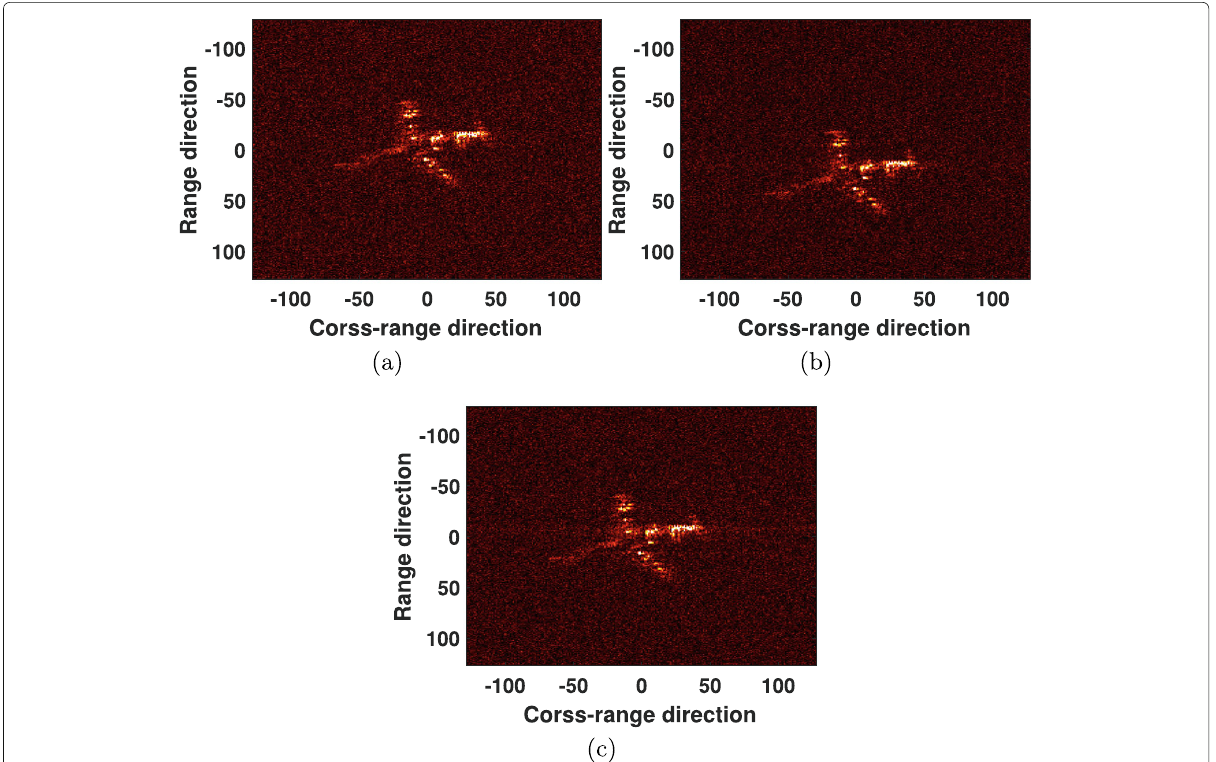
Fig. 11 Imaging results under a − 20 dB SNR. a The imaging result of the proposed algorithm, b the imaging result of the ACM, and c the imaging result of the